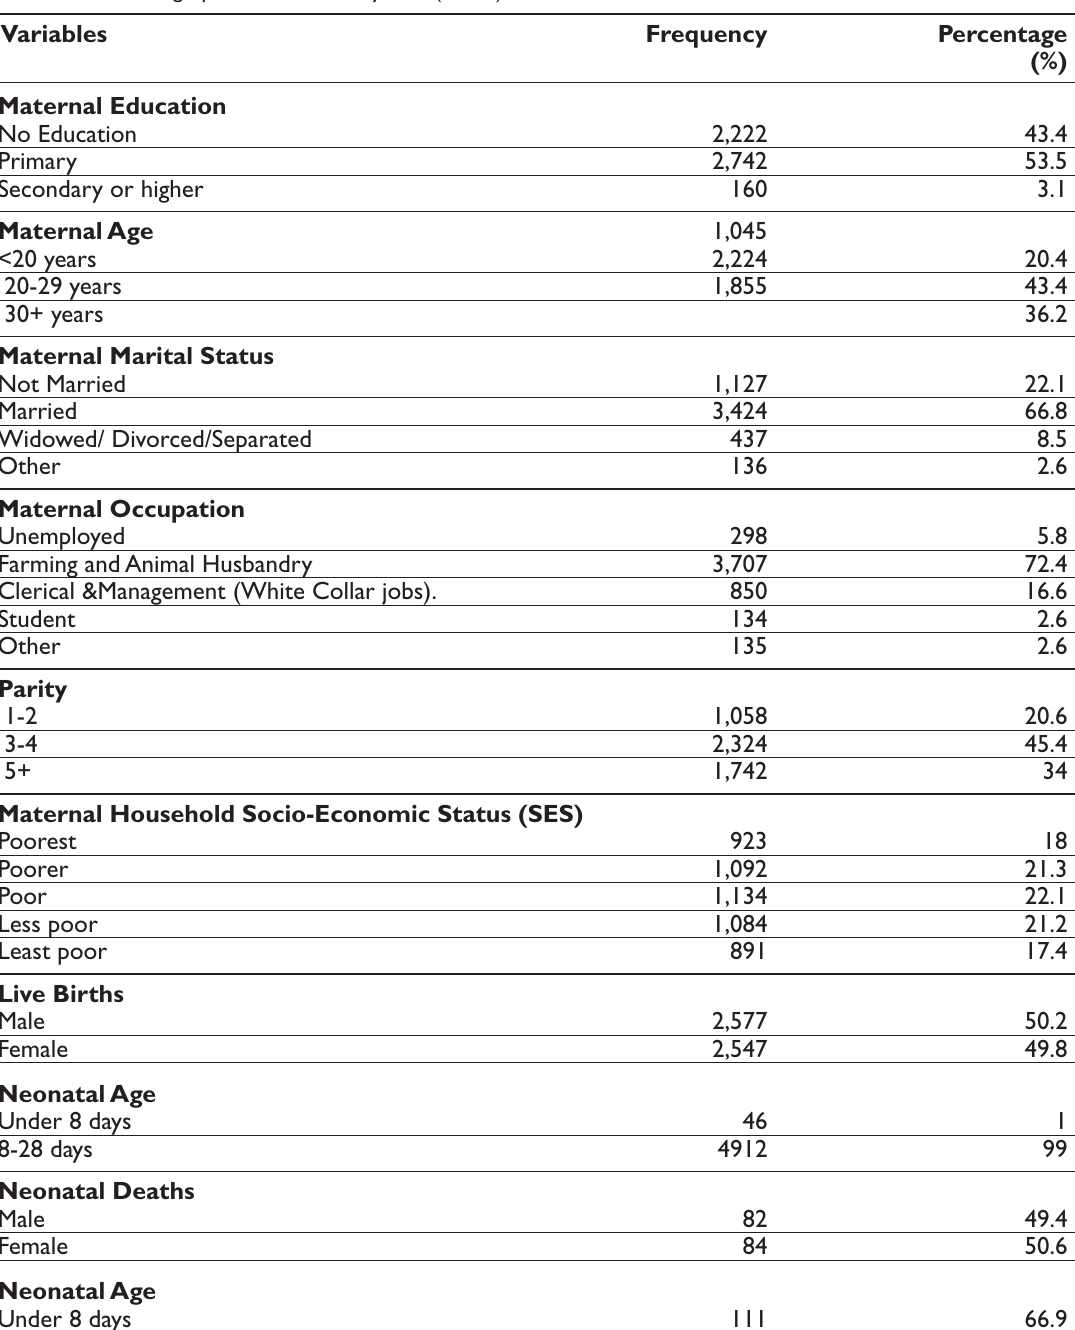
Distribution of Neonatal and Maternal Socio-demographic Characteristics in Rufiji Health and Demographic Surveillance System (HDSS), Tanzania